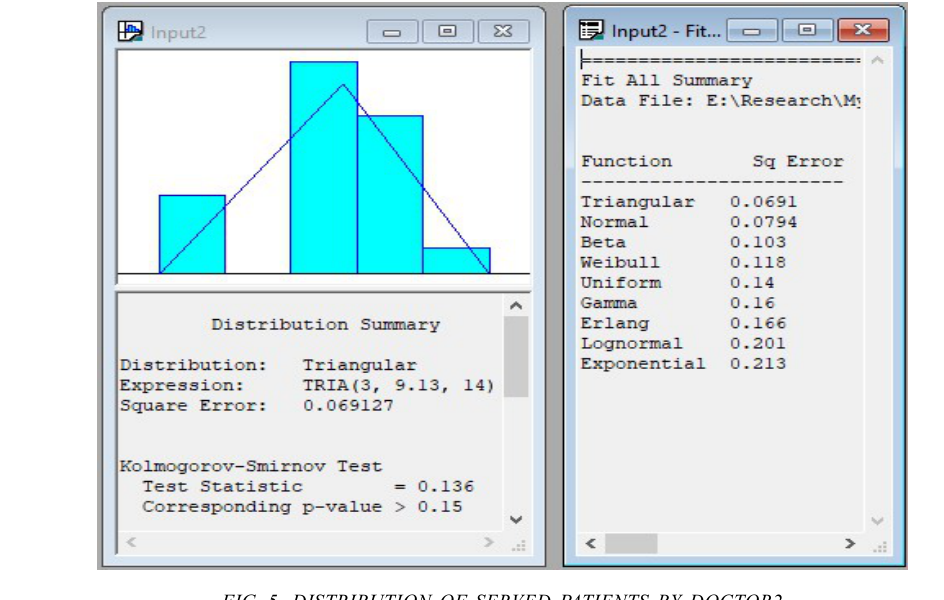
FIG. 5. DISTRIBUTION OF SERVED PATIENTS BY